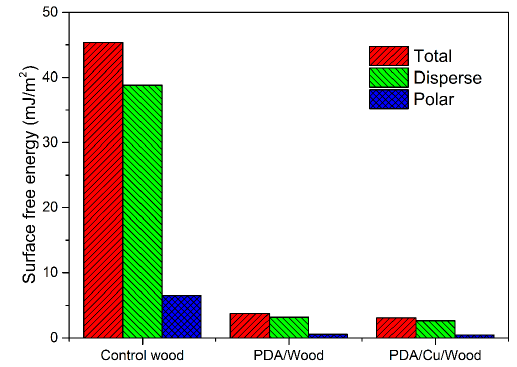
Figure 5. Surface free energy (including total surface free energy, dispersion components and polar components) of control wood, PDA/Wood, and PDA/Cu/Wood samples obtained by the OWRK method.